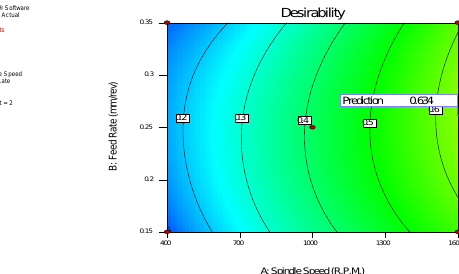
Fig. 13. Ramp function plot for combined for Fig. 14. Contour plot at maximum desirability MRR & Ra value for combined MRR & Ra 5.2 Contour plot at maximum desirability value of